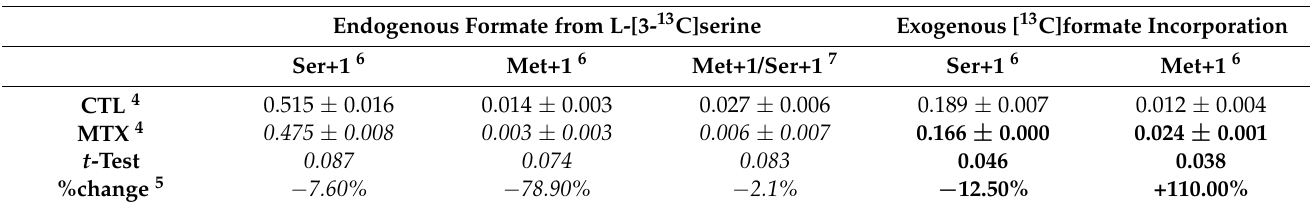
Table 2. Methotrexate (MTX) and folinate (FA) change ( B , D ) the partitioning of 5,10 methyleneTHF 8 (5,10-CH 2 THF) 1C between methionine and thymidylate syntheses from endogenous and exogenous formate; and ( A ) relative incorporation of methylene group and ( C ) the partitioning of mitochondrial and cytosolic derived formate via 5,10-CH 2